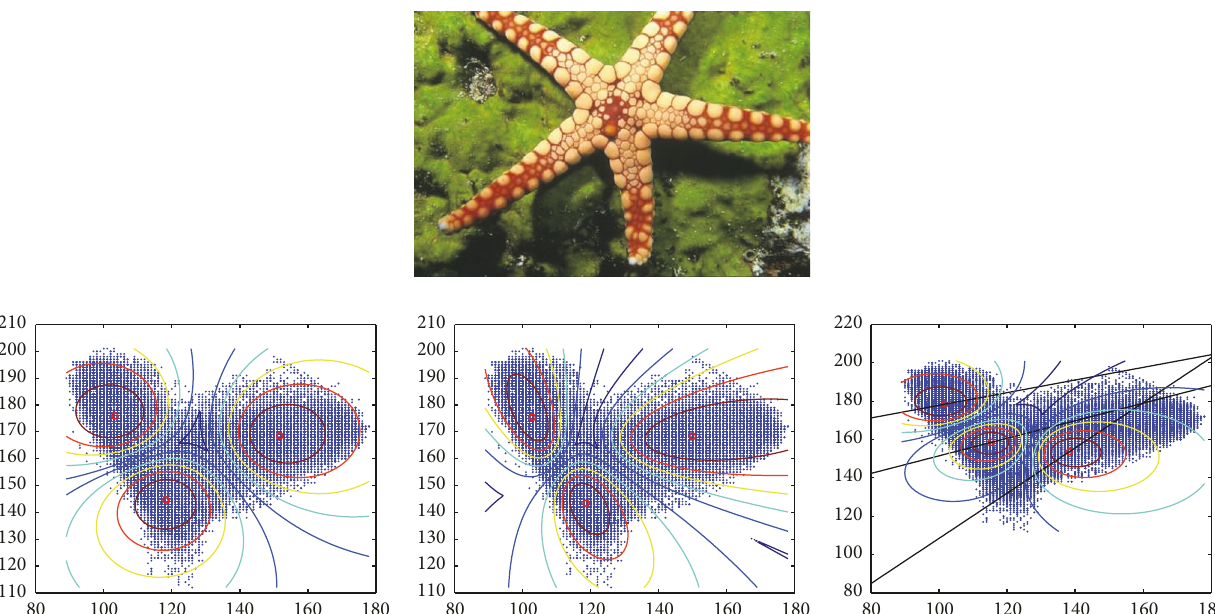
Figure 1: Original image, FCM, GK, and FCRM with 𝑐 = 3 in ∗ a ∗ b color